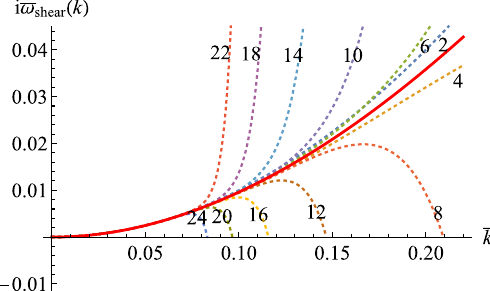
( ¯ ω, ¯ k ) R αβ,γδ ( t , k ) in the R